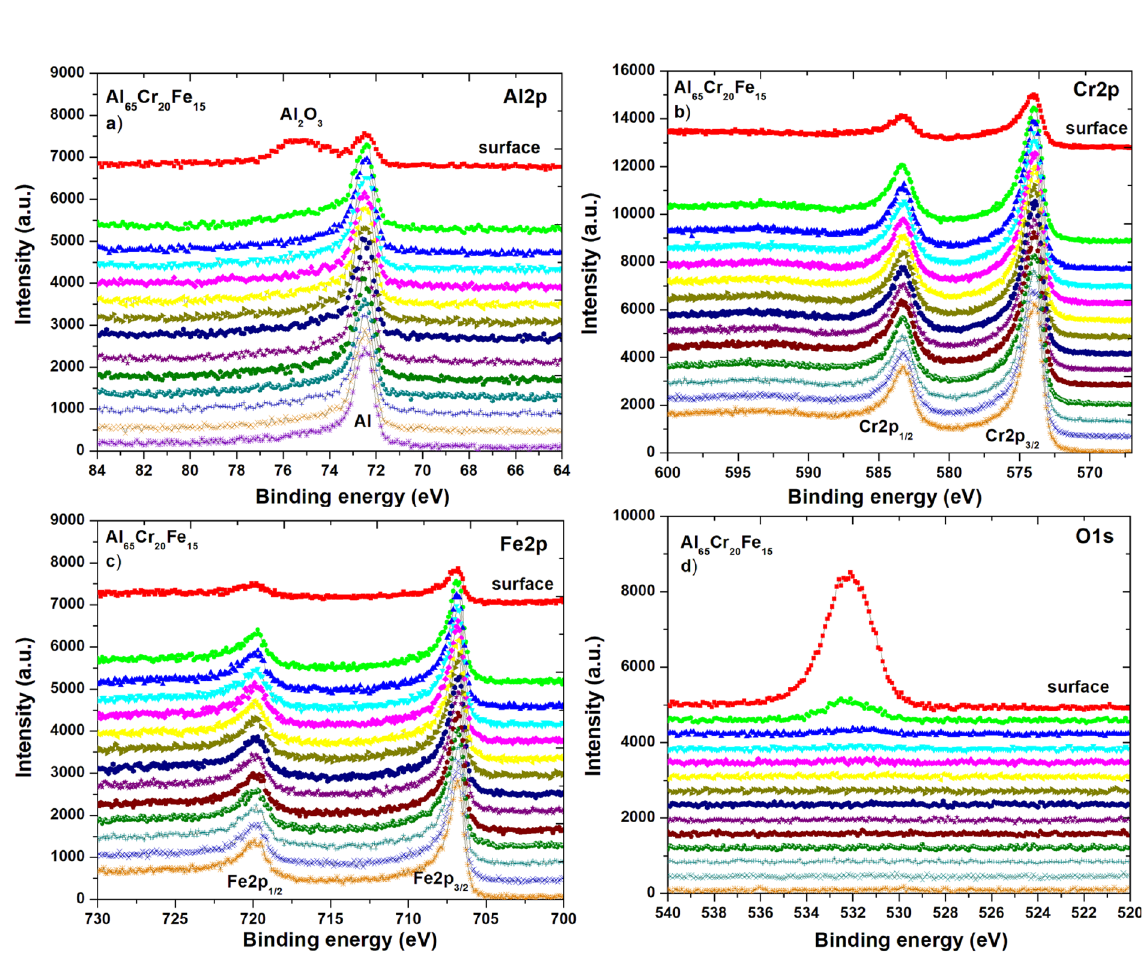
Figure 11. XPS core level lines of Al2 p ( a ), Cr2 p ( b ), Fe2 p ( c ), O1 s ( d ) of Al 65 Cr 20 Fe 15 plate after corrosion tests in 3.5% NaCl solution at 25